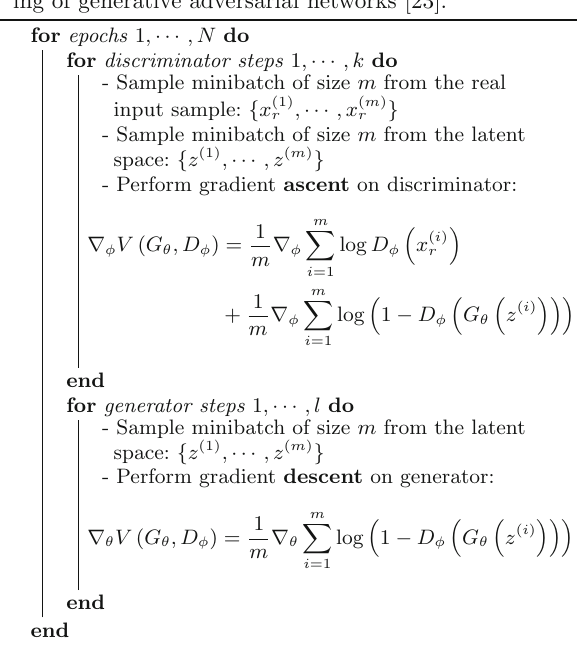
Algorithm 1 is a typical formulation of a